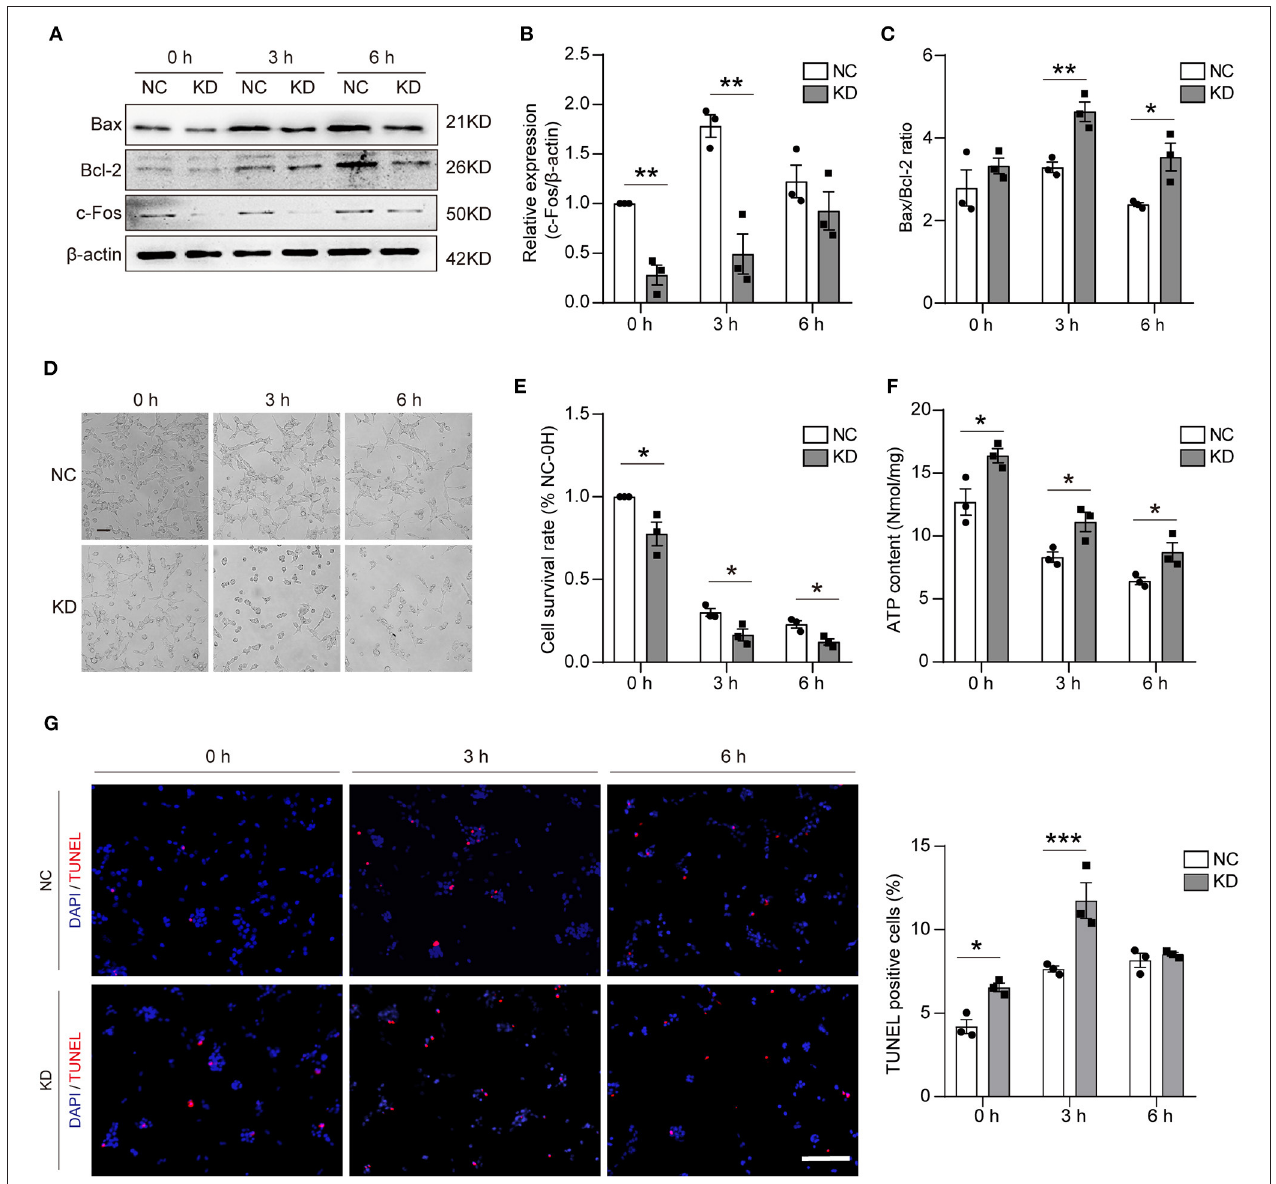
FIGURE 6 | Apoptosis was aggravated in the KD group after OGD. (A–C) Representative WB bands and quantification of c-Fos, Bax, and Bcl-2 expression levels. (D,E) Cell morphology and cell survival rate at 0, 3, and 6h. Scale bar = 50 µ m. (F) ATP content (nmol/mg) was detected by an ATP Assay Kit. (G) The TUNEL-positive cells were labed by red, and the nuclear (DAPI) was labeled by blue. Scale bar = 100 µ m. Each result is expressed as the mean of three independent experiments ± SEM. * p < 0.05, ** p < 0.01, *** p < 0.001. NC, negative control cells; KD, knock-down